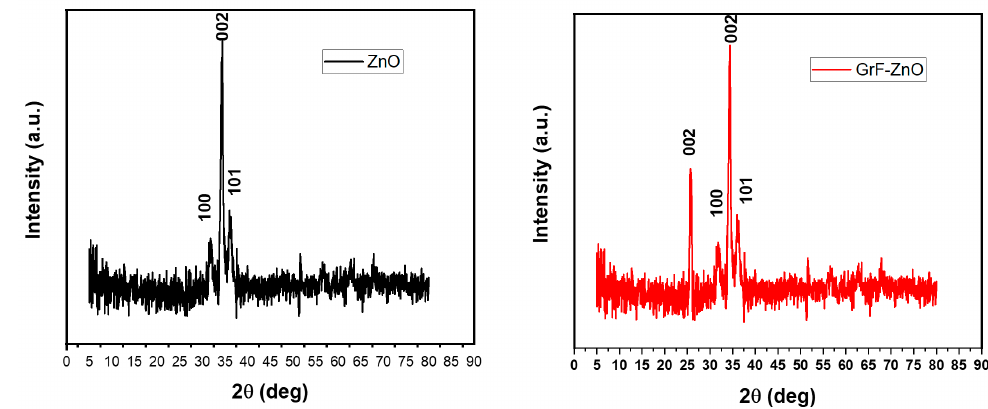
Figure 6. XRD analysis of ( a ) ZnO thin film; ( b ) GrF/ZnO composite.